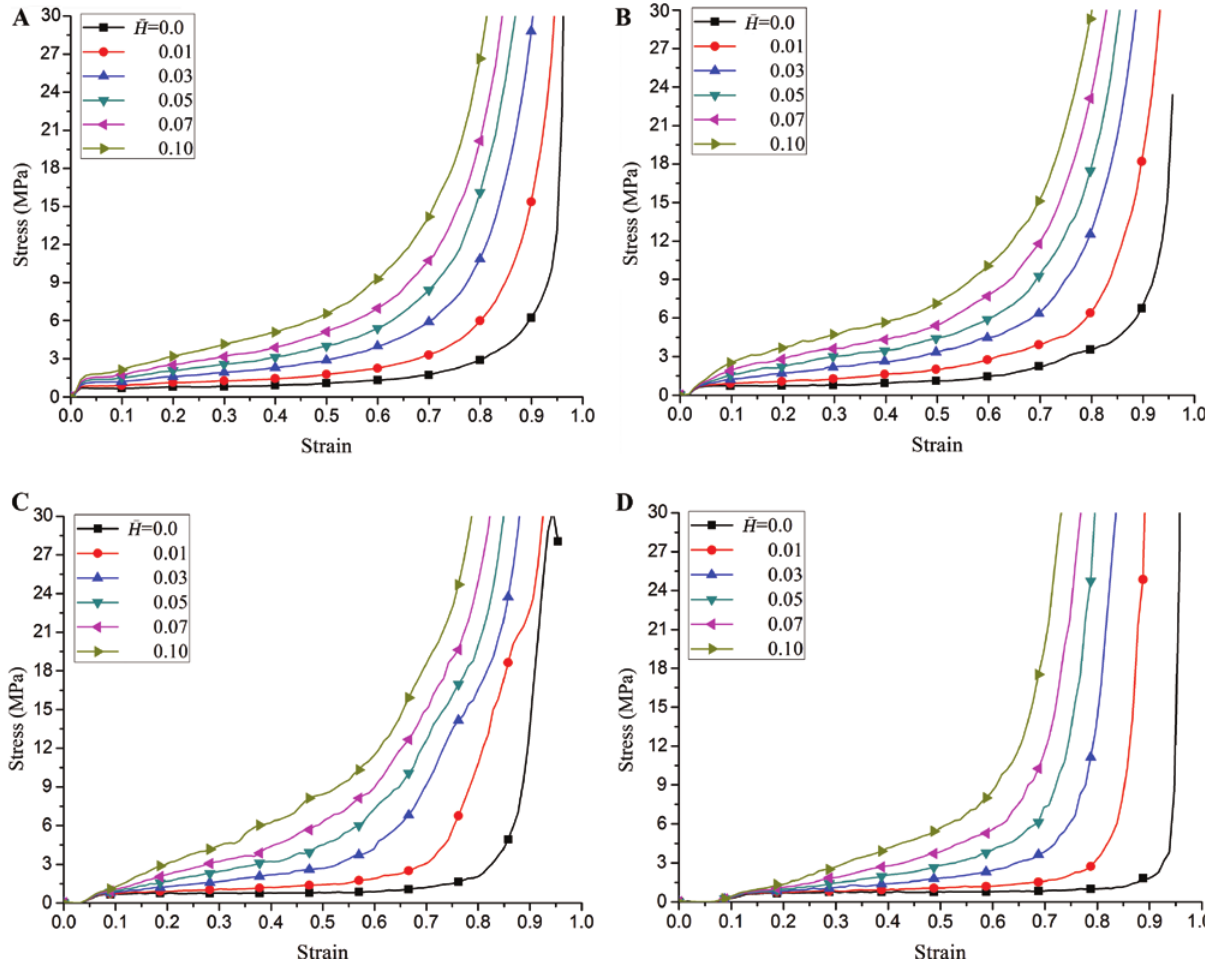
Figure 6: Crushing stress variation at the stationary side (A, 10 m/s; B, 50 m/s; C, 120 m/s; D, 250 m/s).